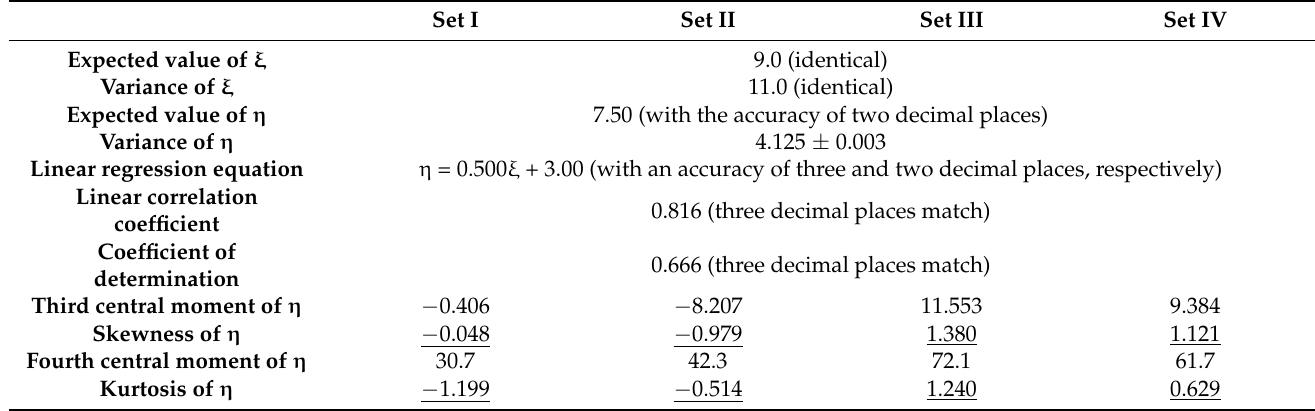
Figure 5. Graphical representation of the datasets from the Anscombe quartet: ( a ) Set I, ( b ) Set II, ( c ) Set III, ( d ) Set IV. Table 4. Statistical parameters for the four datasets from the Anscombe quartet (the most important differences are